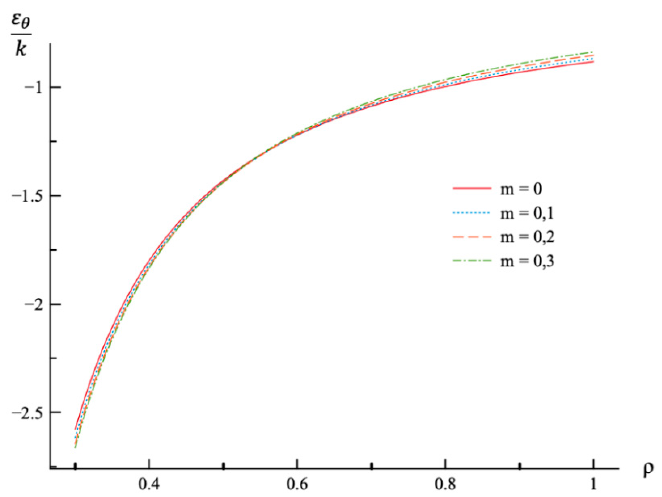
Figure 4. Variation of the circumferential strain, θ